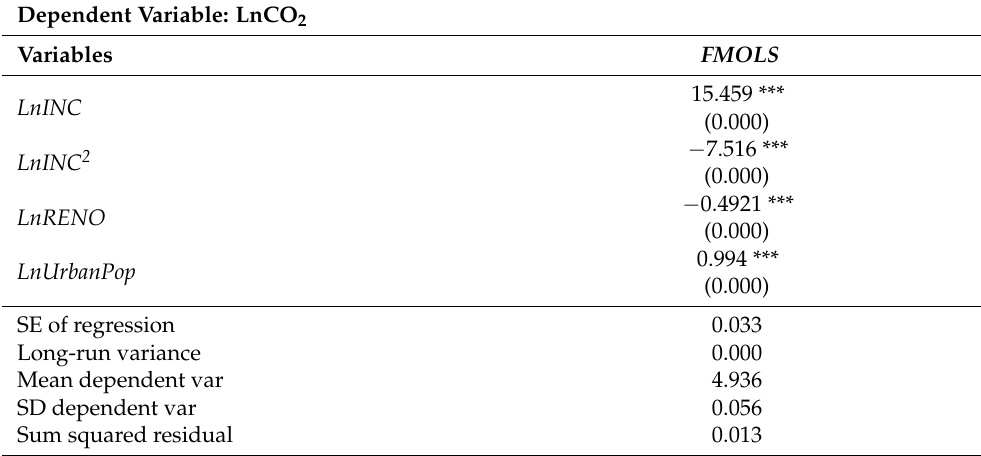
Table 8. Testing the impact of Environmental Kuznets Curve with Panel Fully Modified Least Squares estimator.